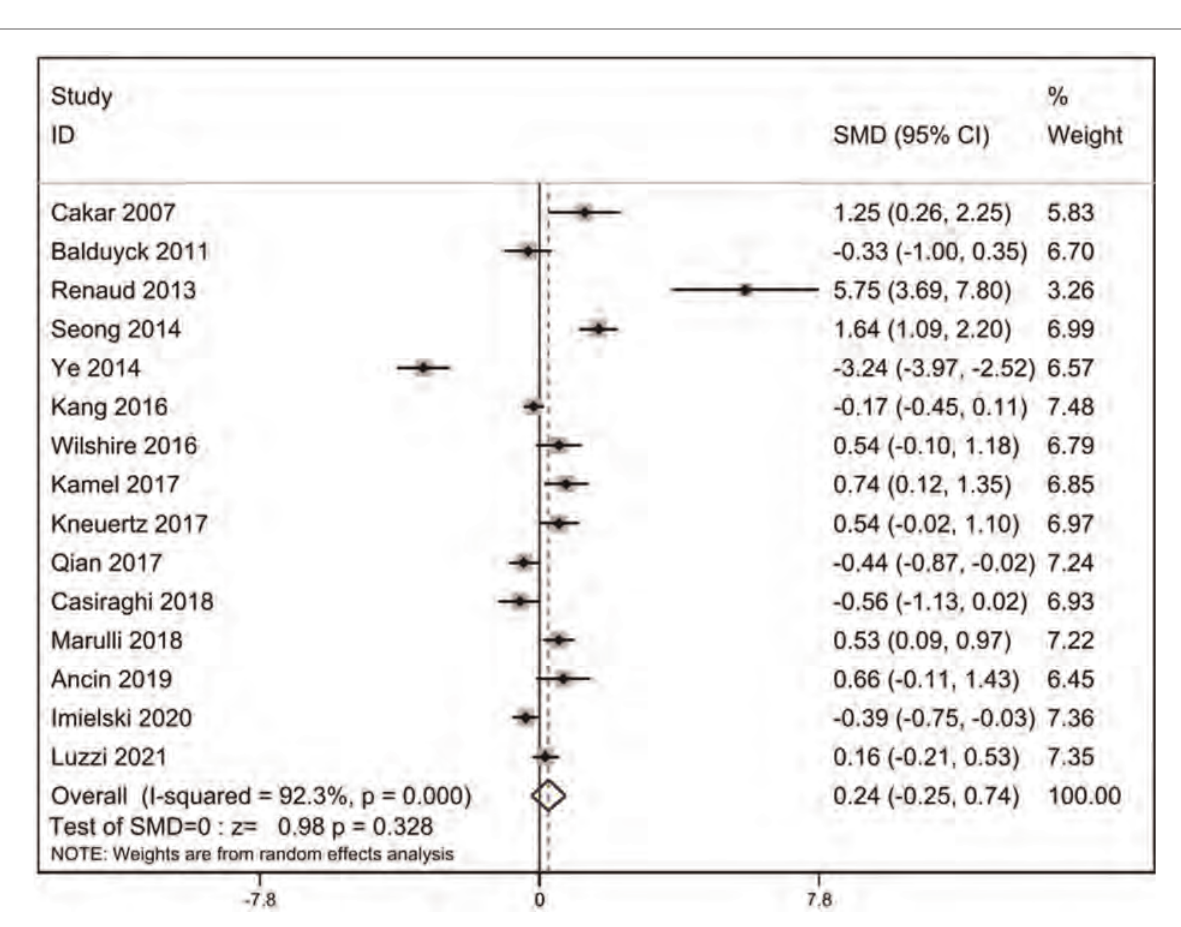
FIGURE 3 Comparison of operation time between RATS and ST. SMD, standardized mean difference; CI, con fi dence interval; RATS, robot-assisted thoracoscopic surgery; ST,